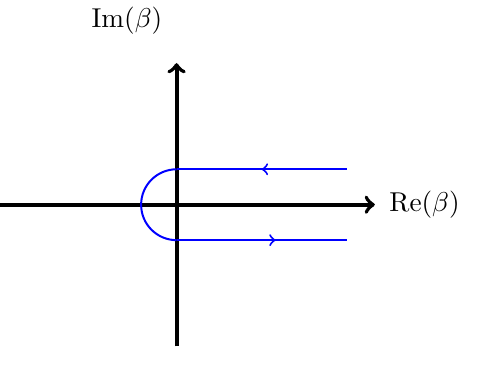
Figure 2 . Hankel